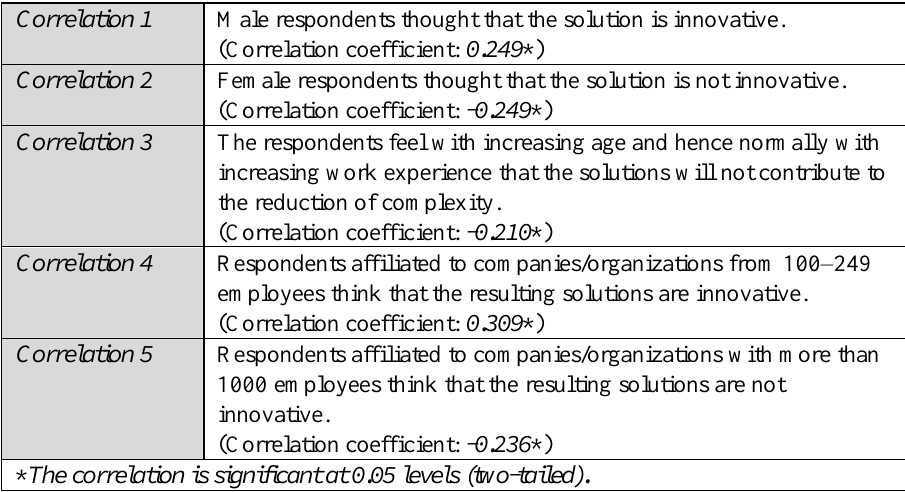
Table 1. Correlations between the first and the second parts of survey